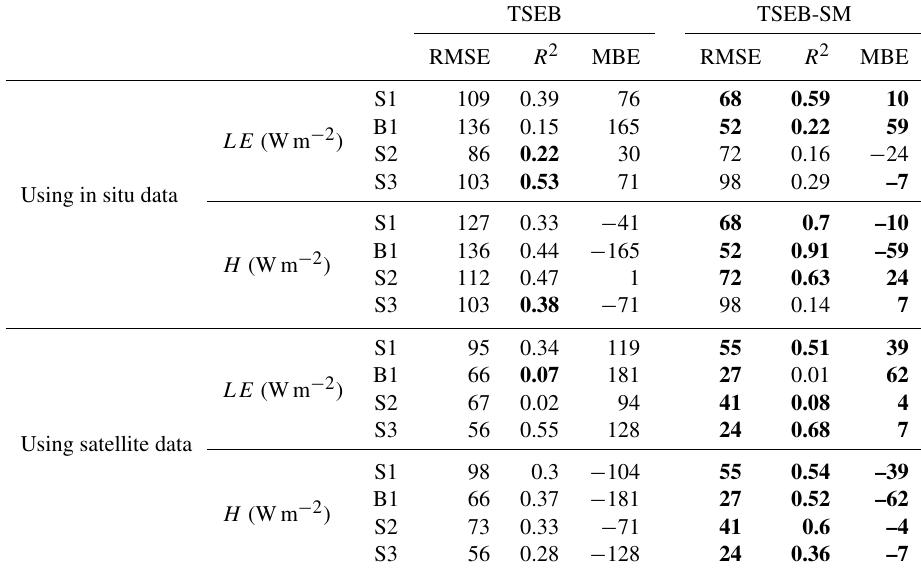
Figure 8. Scatterplot of simulated versus observed LE for (top panels) TSEB and (bottom panels) TSEB-SM models using in situ data collected during S1, B1, S2 and S3, respectively. Table 4. Statistical results (RMSE, R 2 and MBE) between modeled and measured sensible and latent heat fluxes for S1, S2, B1 and S3, and for TSEB and TSEB-SM models, separately ( R n and G are forced to their measured value). Bold values are the values with better statistical